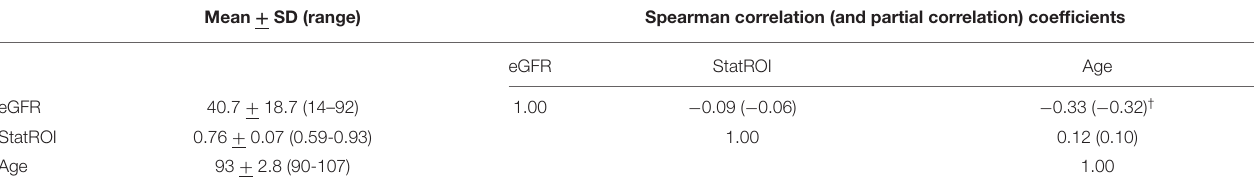
TABLE 2 | Spearman correlation and partial correlation coefficients of estimated glomerular filtration rate (eGFR), brain amyloid- β positron emission tomography statistically defined region of interest scores (PET statROI), and age (years), The 90 + Study.